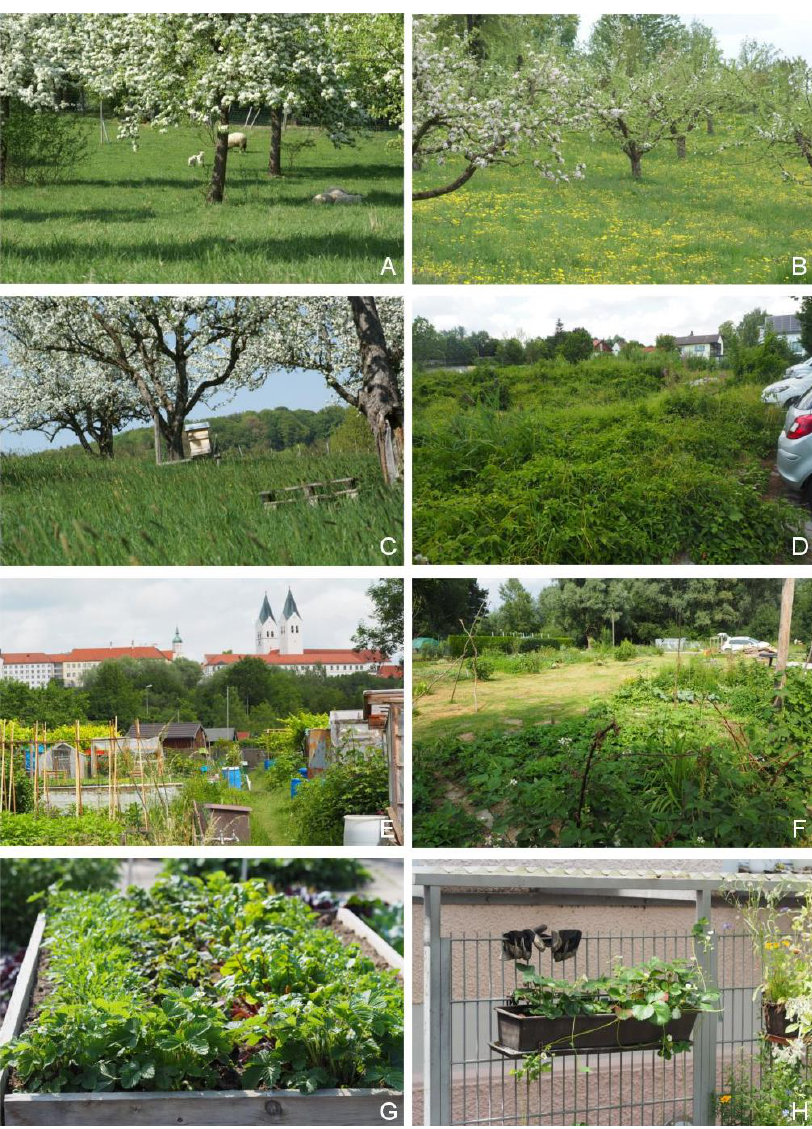
Figure 2. Examples of study